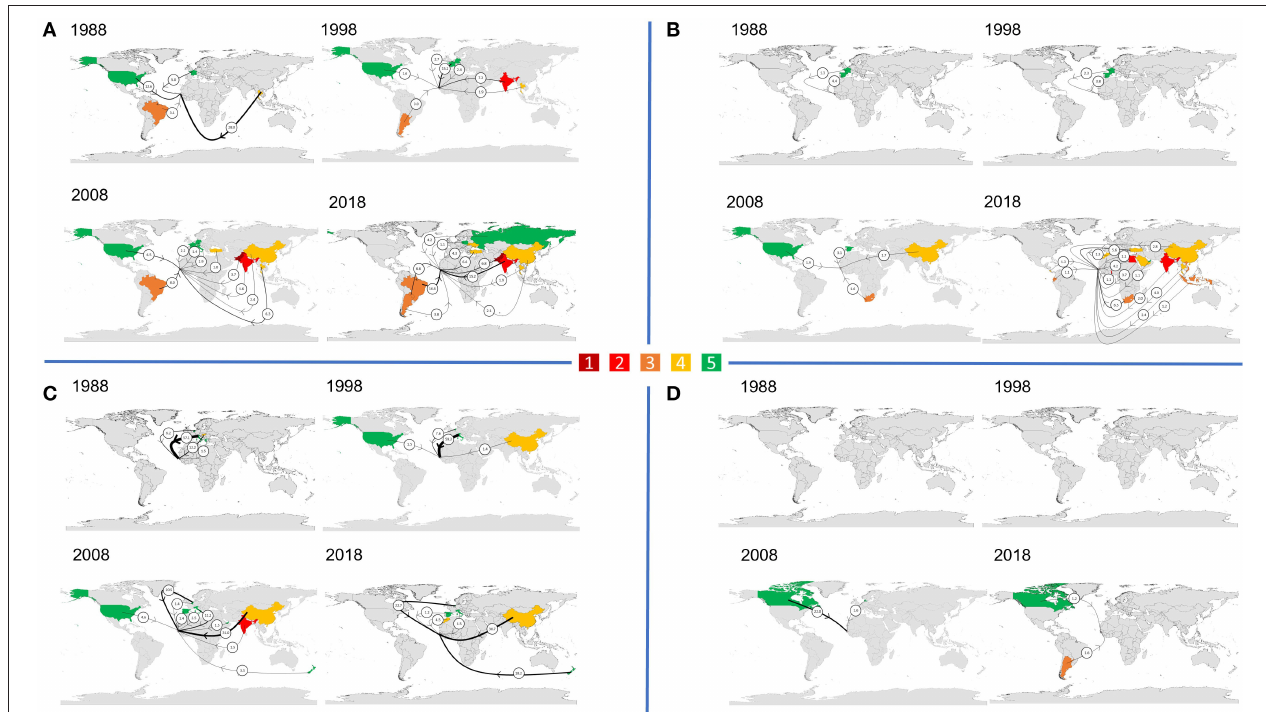
FIGURE 3 | Climate vulnerability of trade partners (ND-GAIN index) contributing ≥ 1% of supply of (A) cereals (B) fruits (C) vegetables, (D) pulses, in 1988, 1998, 2008, and 2018. Amount the imported crop contributes to supply is represented by arrow thickness (not to scale) and numbers (%). There are five climate vulnerability categories: [1–dark red] Extreme; [2–red] High; [3–orange] Intermediate to high; [4–yellow] Intermediate; [5–green] Low.